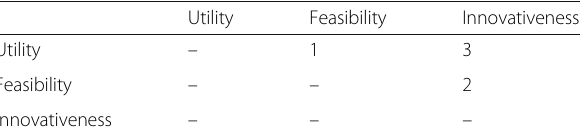
Table 3 Weight elicitation process: pairwise comparison of the criteria